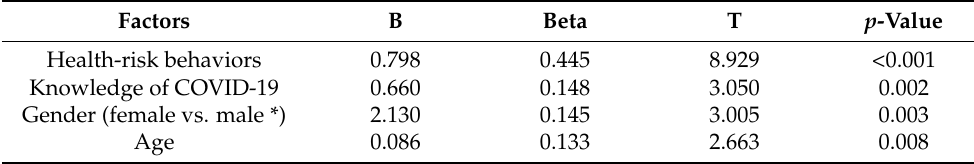
Table 4. Variables predicting participant’s COVID-19 preventive